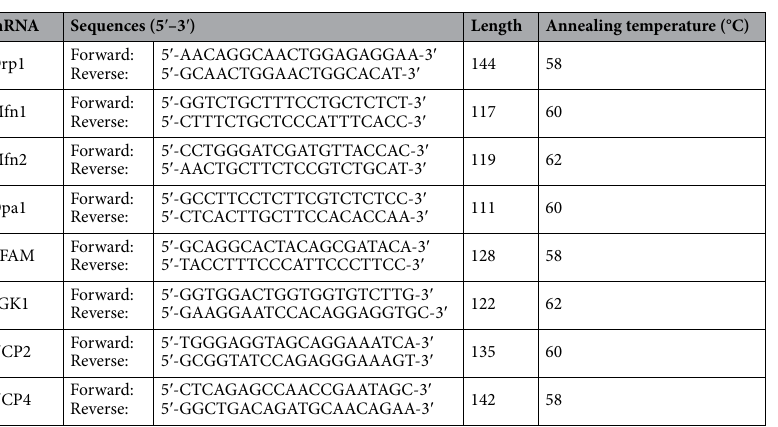
mRNA Sequences (5 ′ –3 ′